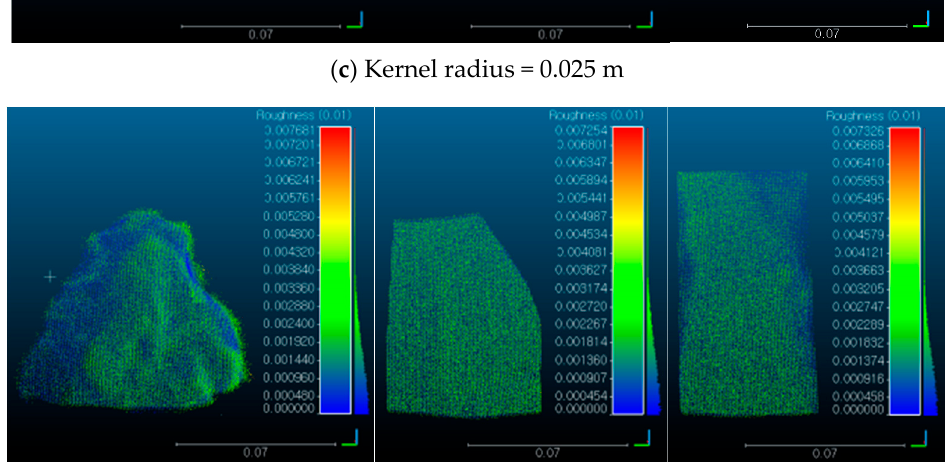
tained with a point cloud containing many points. However, the scanning and analysis time is increased with the increase of the number of points. In this paper, a kernel size of 0.05 m, which reflects the roughness of three samples properly, was used to analyze the calculation of roughness regarding the density change of the point cloud. Subsamples with 100,000, 10,000, 5000, and 1000 points were extracted from 135,000 original point clouds to evaluate the roughness, and compared with the roughness of the original point cloud. Figure 13a shows a histogram in which roughness was determined by subsamples with 100,000 points. There is no significant difference with the results of the original point cloud in Figure 11b. Table 1 shows the roughness at which the number of points reached 95% in each sample. All three samples with 100,000 points have an error of less than 0.6% compared to the results of the original sample. When the number of points is reduced to 10,000, the histogram is similar to the original point cloud (see Figure 13b). In the grouting, sand and gravel samples, the roughness at which the number of points reached 95% was 5.76, 6.05, and 1.19 mm. The roughness of the sand and gravel samples showed an error of about 2% compared to the results of the original point cloud. The fluctuation between the roughness classes in the histogram becomes larger if the number of points is decreased to 5000 (see Figure 13c). Therefore, the distribution of points in individual roughness clas- ses of the histogram is unstable. The roughness at which the number of points in each sample reached 95% has an error of about 2% compared to the result of the original point cloud. In the results of 1000 points, the fluctuation of histogram is larger than the others and the slope of the histogram is steeper within a roughness class of 5 mm (see Figure 13d). The roughness at which the number of points in the gravel sample reached 95% is increased to about 4% compared to the result of the original point cloud. The histograms of grouting and sand samples cannot be distinguished as well. ( a ) Number of points = 100,000